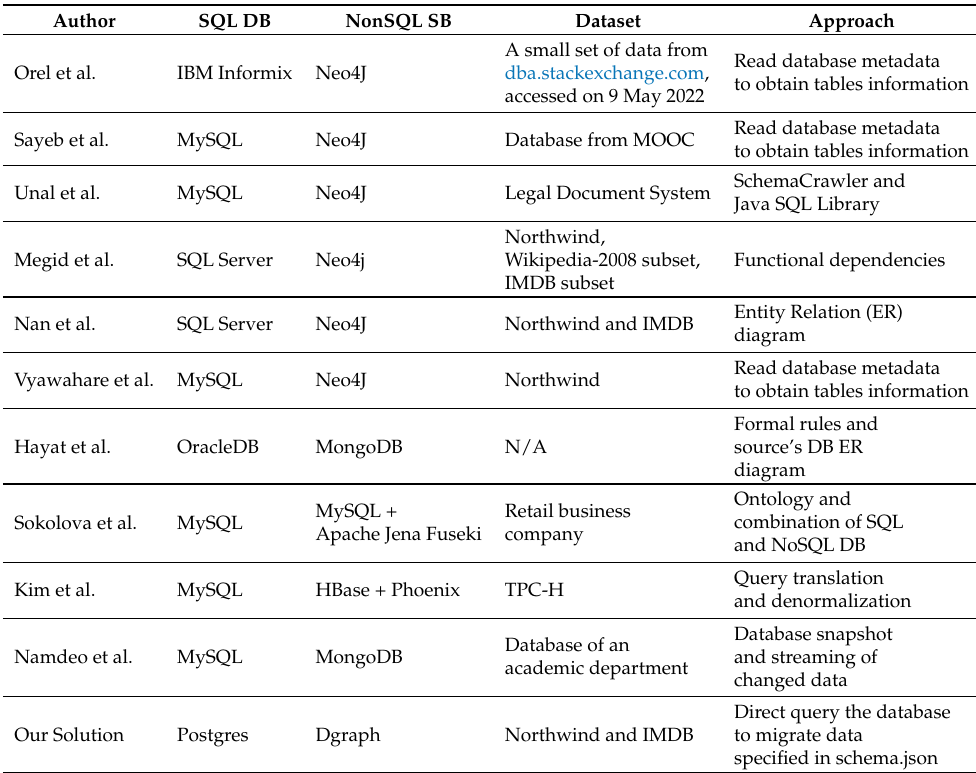
Table 1. Related